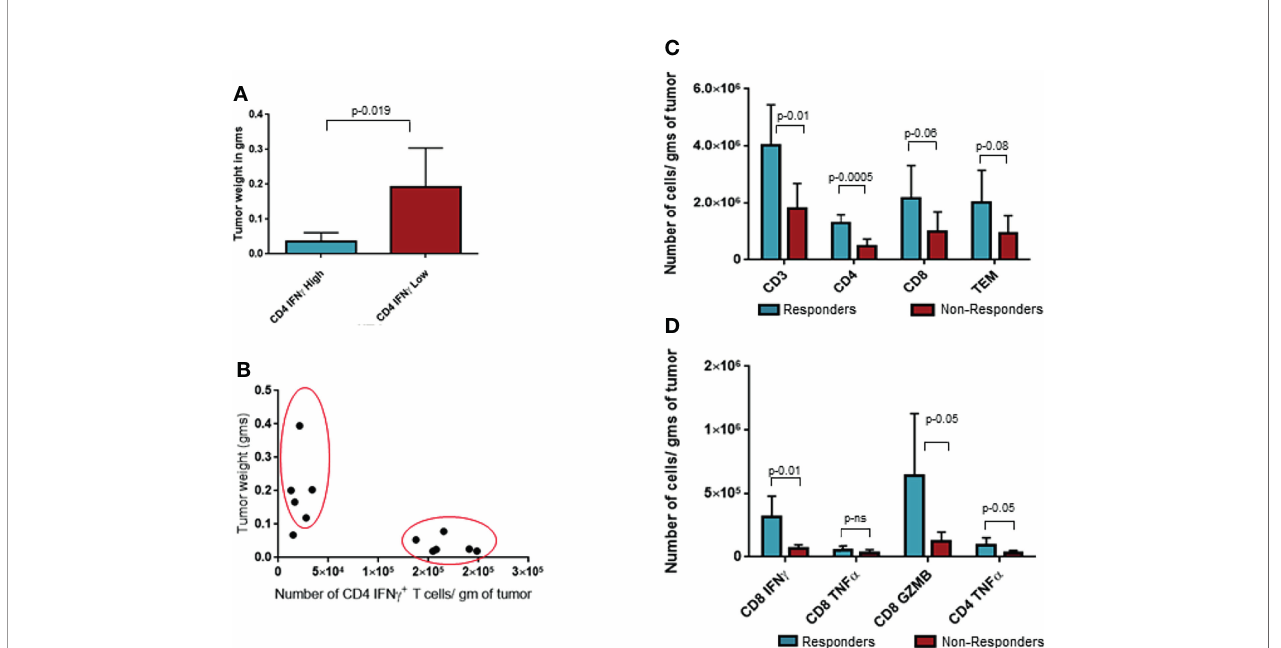
FIGURE 5 | Analysis of responders and non-responders based on CD4 Interferon g expression levels. (A) Tumor weight data in grams for two groups of ITI-1001- treated tumors based on the two populations of CD4 Interferon g high and low levels observed in Figure 3B . (B) Unbiased correlation plot between tumor weight and CD4 Interferon g + samples. Correlation coef fi cient r-(-0.71). (C) Evaluating the differences between the responders and non-responders for T-cell population. (D) Evaluating the differences between the responders and non-responders for activated CD8 and CD4 T cells using IFN g + and TNF a + expression. All the populations are denoted as cell numbers per gram of tumor. p values from Student ’ s t-test are denoted to signify the statistical differences between responders and